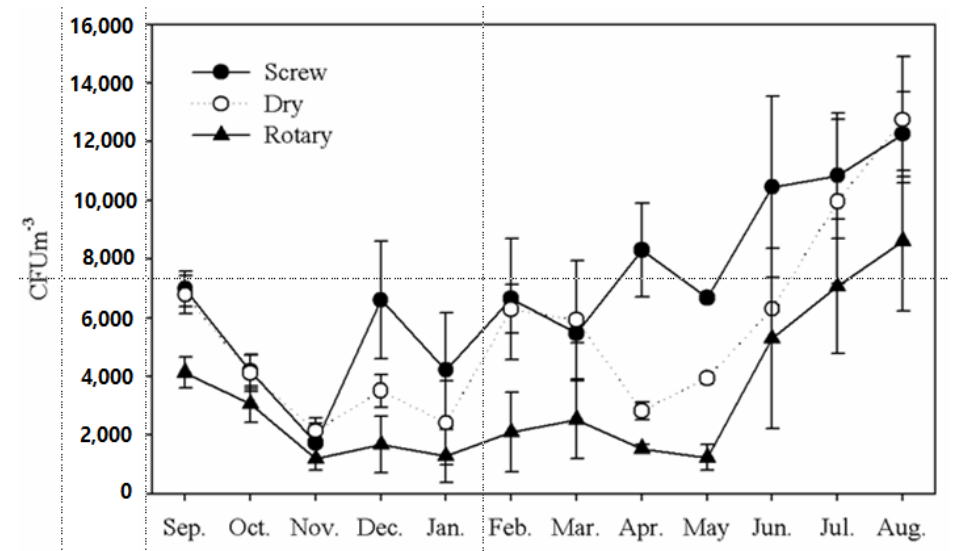
Figure 1. Monthly mean concentration trend of airborne bacteria in swine manure composting plants.